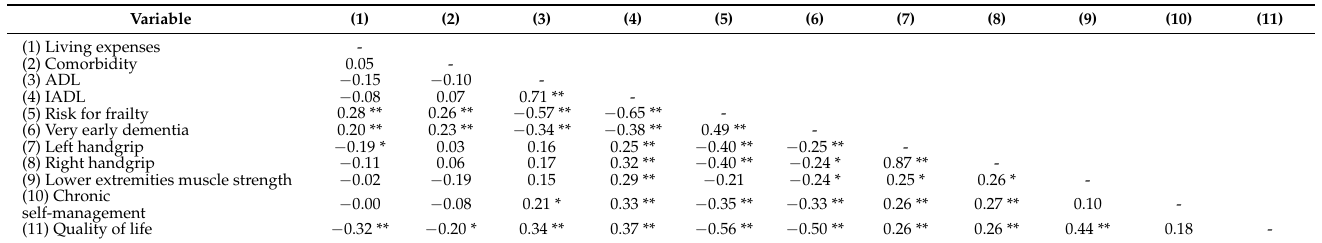
Table 4. Correlations among chronic disease self-management, health status, and quality of